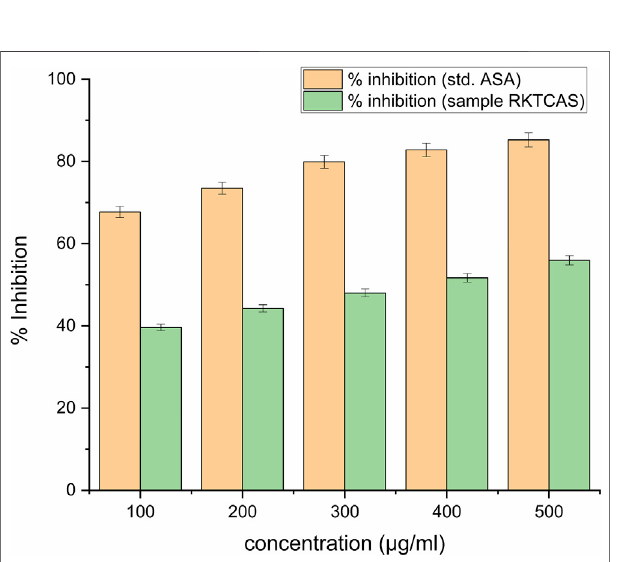
FIGURE 7 | In-vivo anti-arthritic activity (joint diameter in mm). All the values are expressed as Mean ± SEM ( n (cid:2) 6) ** p < 0.01 (G2 vs. G4); *** p < 0.001 (G2 vs. G3, G4 and